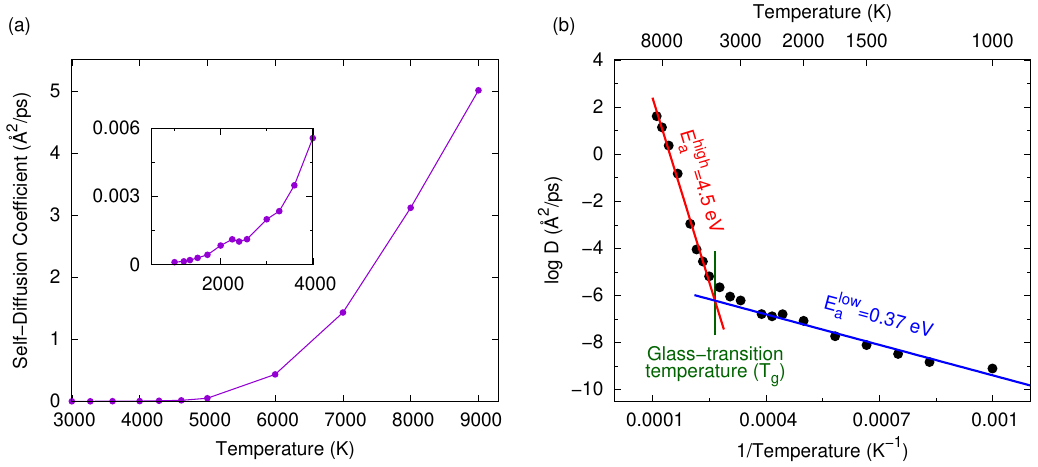
Figure 3. ( a ) Self-diffusion coefficient as a function of temperature at 1.5 g/cc using the Tersoff potential. Inset shows a close-up for the lower temperatures. ( b ) Same data on an Arrhenius plot, revealing two activation energies ( E high a and E low a ) and the glass-transition temperature ( T g ). The red and blue lines are linear fits to the